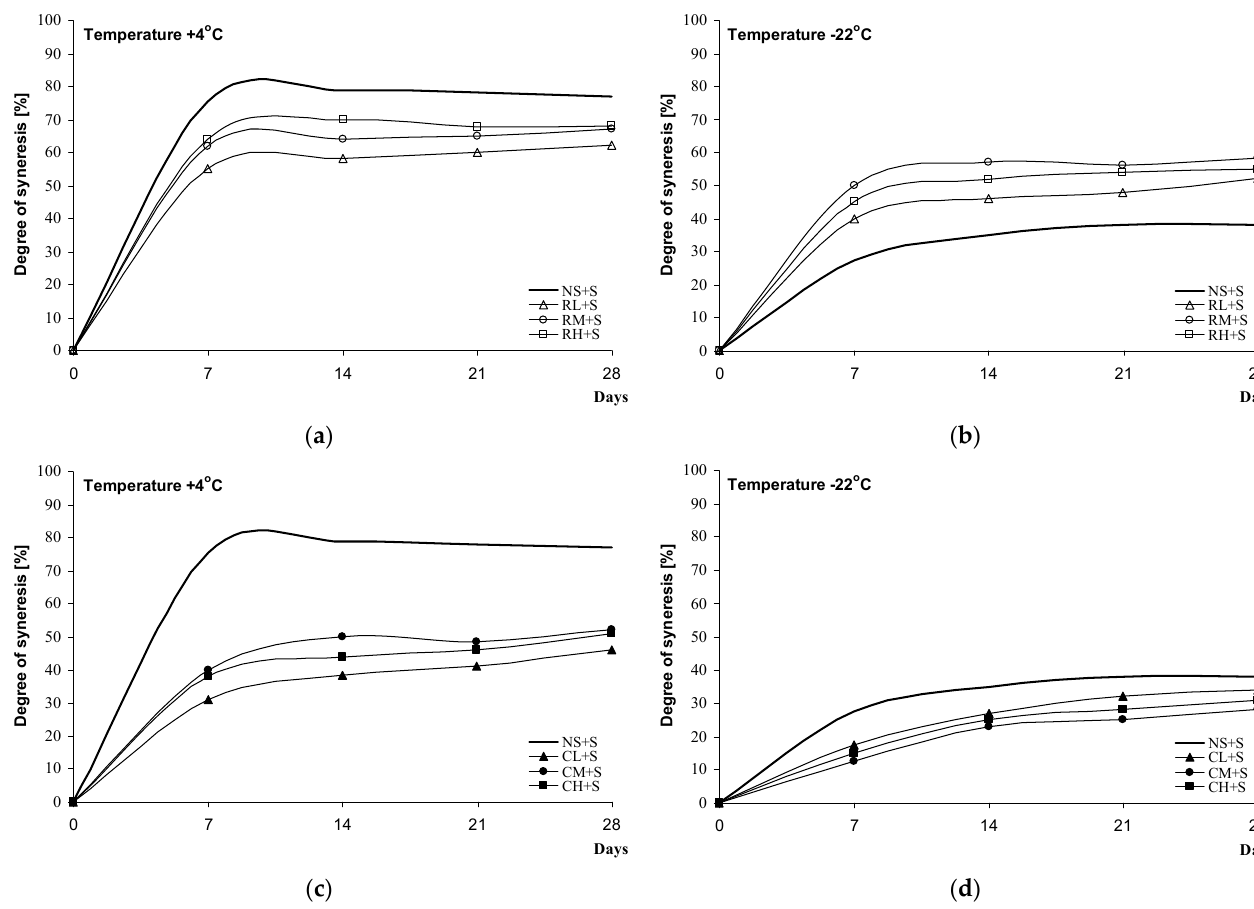
Figure 6. Syneresis of black jelly-like desserts prepared on the basis of chemically ( a , b ) or physically ( c , d ) modified starches sweetened with sucrose.